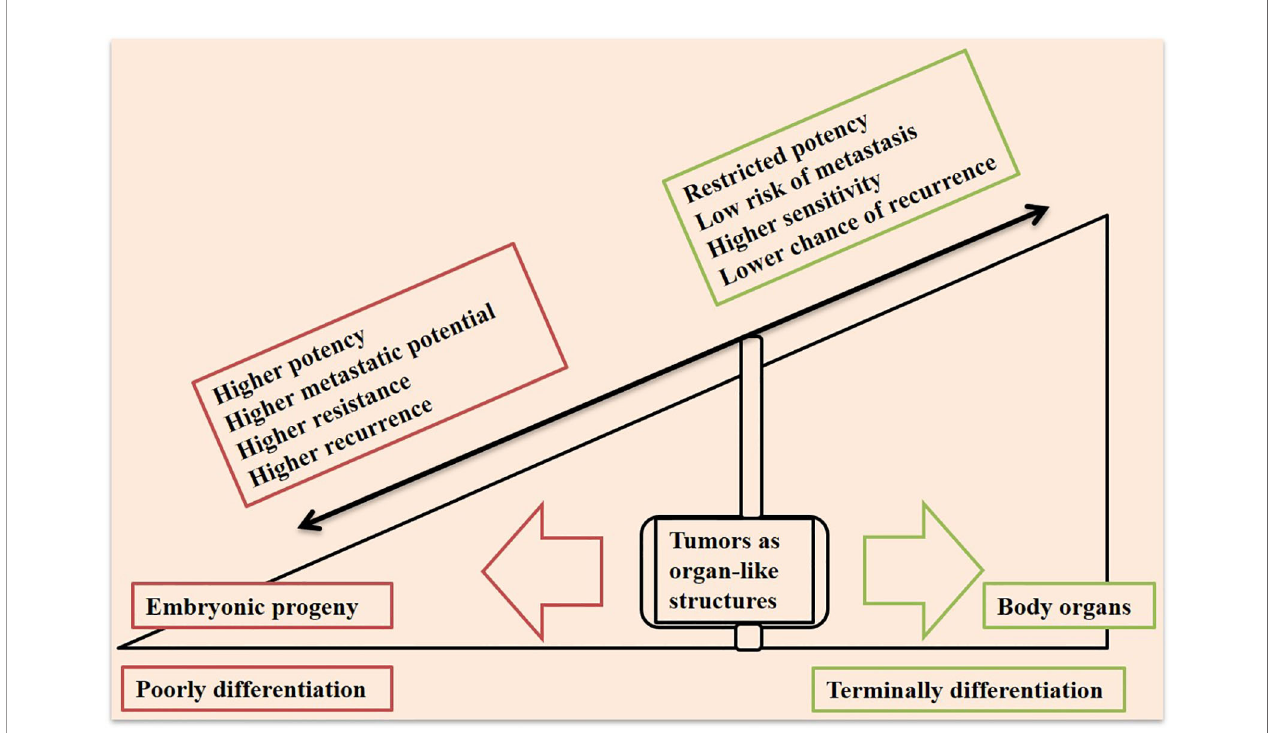
FIGURE 1 | Tumors at the interface of a poorly differentiated embryonic progeny and terminally differentiated body organs. Tumors are organ-like structures that represent a pack of immature cell types, which bring them higher capacities to promote resistance, relapse, and metastasis. A tumor closer to the embryonic progeny displays higher progressive potency, whereas a more differentiated cellular state in a tumor will bring higher sensitivity to